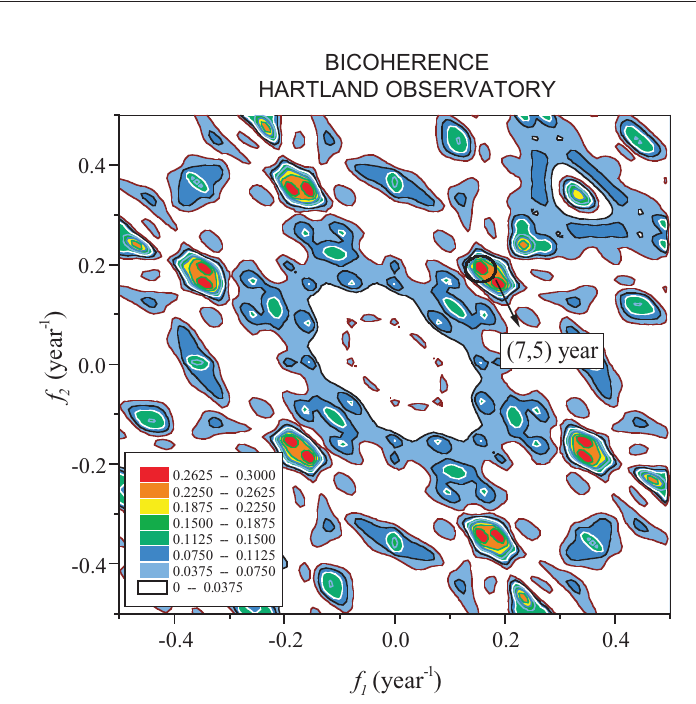
Fig. 6. Estimation of bicoherence for the Y component of geomagnetic field SV. It returns a quadratic coupling between 7 and 5 years.